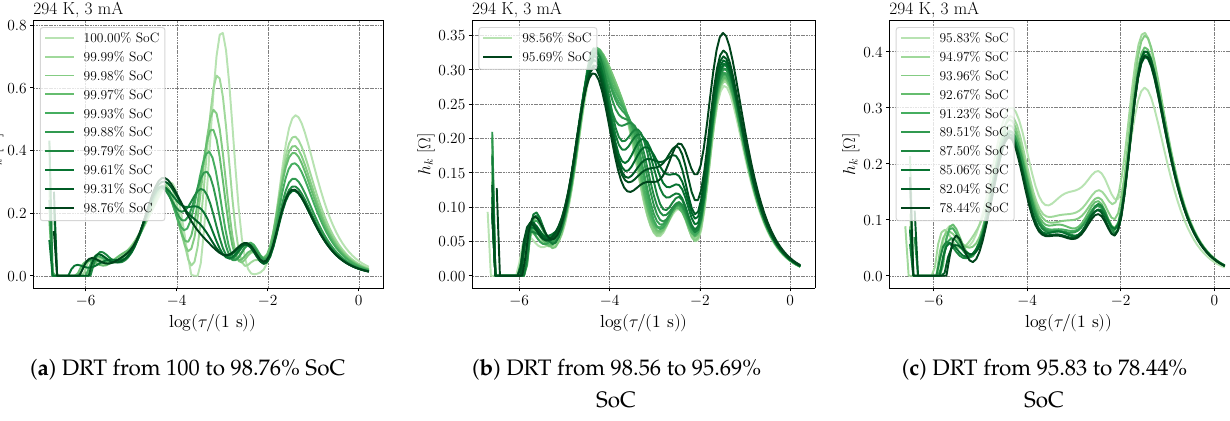
Figure 9. Process analysis of the first and second operating phase of a ZAB at 294 K and a discharge current of 3 mA. ( a , c ) represent 10 logarithmically extracted values from the data set, respectively, and ( b ) depicts 20 linear SOC steps in a range from 98.56% to 95.69%